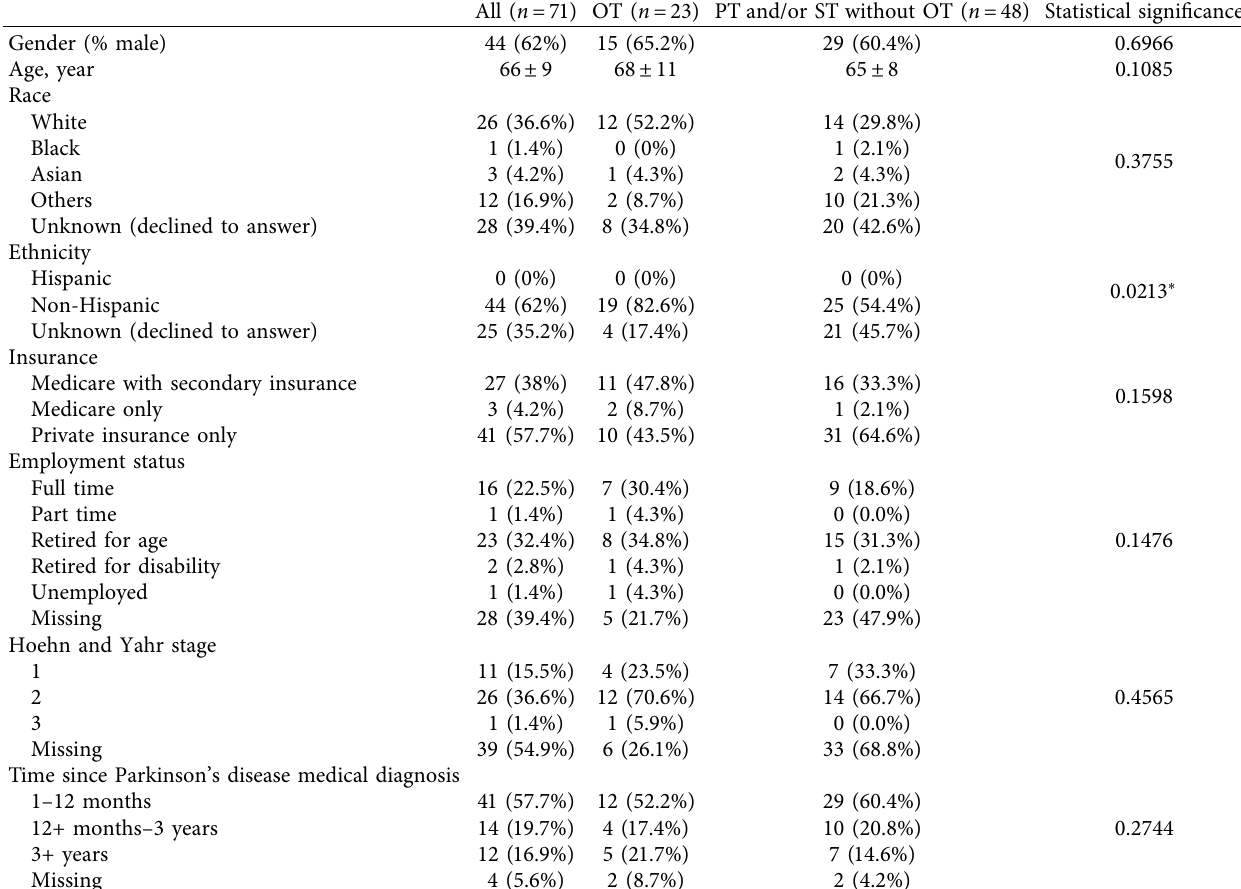
Table 1: Demographic and Parkinson’s disease-specific characteristics ( n �